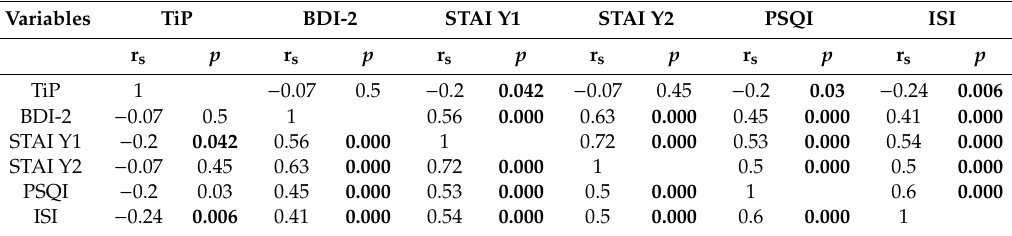
Table 3. Spearman’s r s (and related level of significance) between TiP and STAI Y1 and Y2, PSQI, ISI, and BDI-2 total